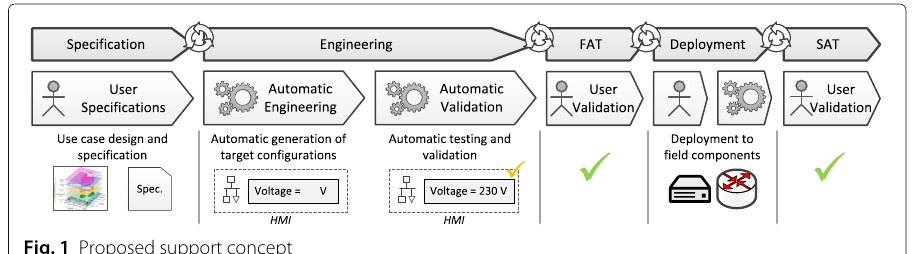
Fig. 1 Proposed support